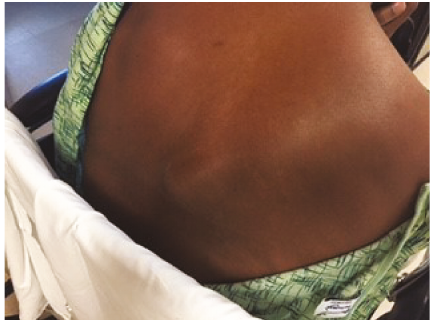
Figure 1: Initial clinical presentation of